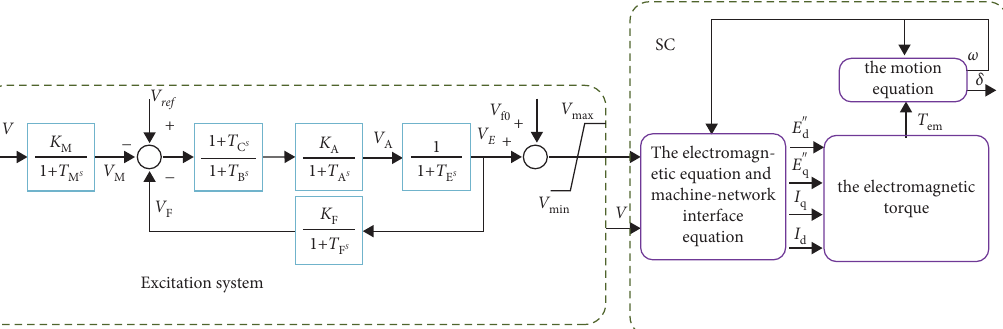
Figure 1: Model of SC.